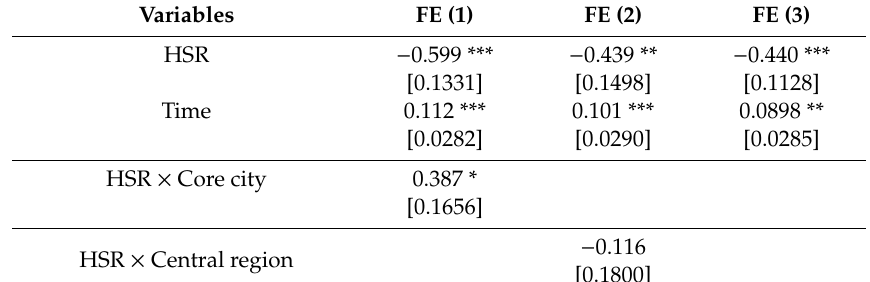
Table 7. Test of the e ff ect of the HSR connection under di ff erent types of heterogeneity. Variables